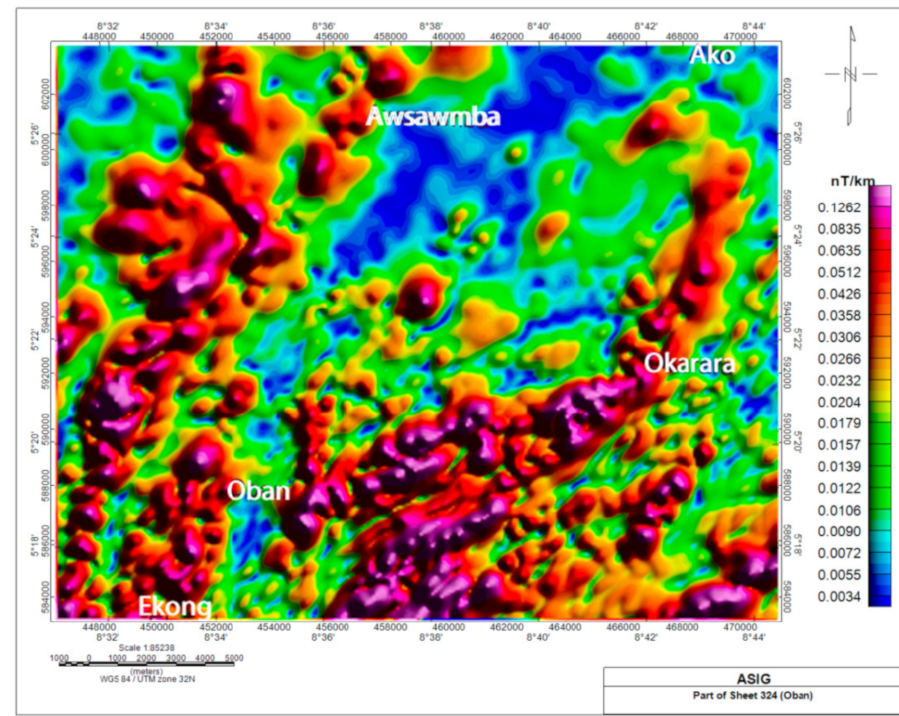
Figure 10. Analytical signal magnitude map.